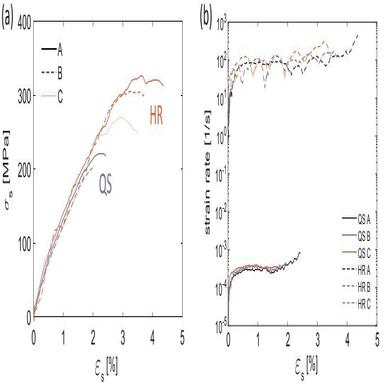
Stress-strain and strain rate-strain curves for DENT specimen under QS (a) and HR (b) loading.